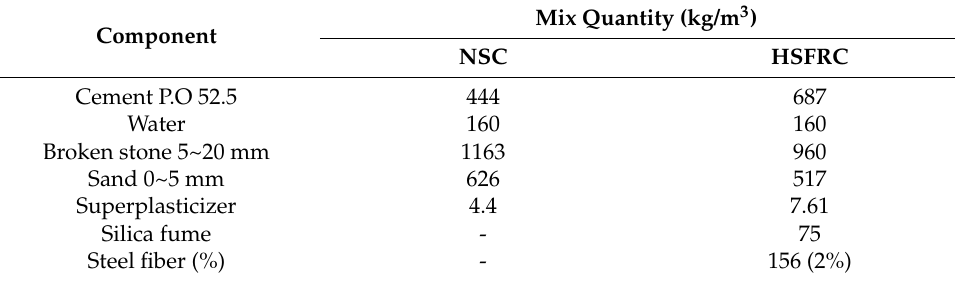
Table 2. The mixture proportions of concretes.